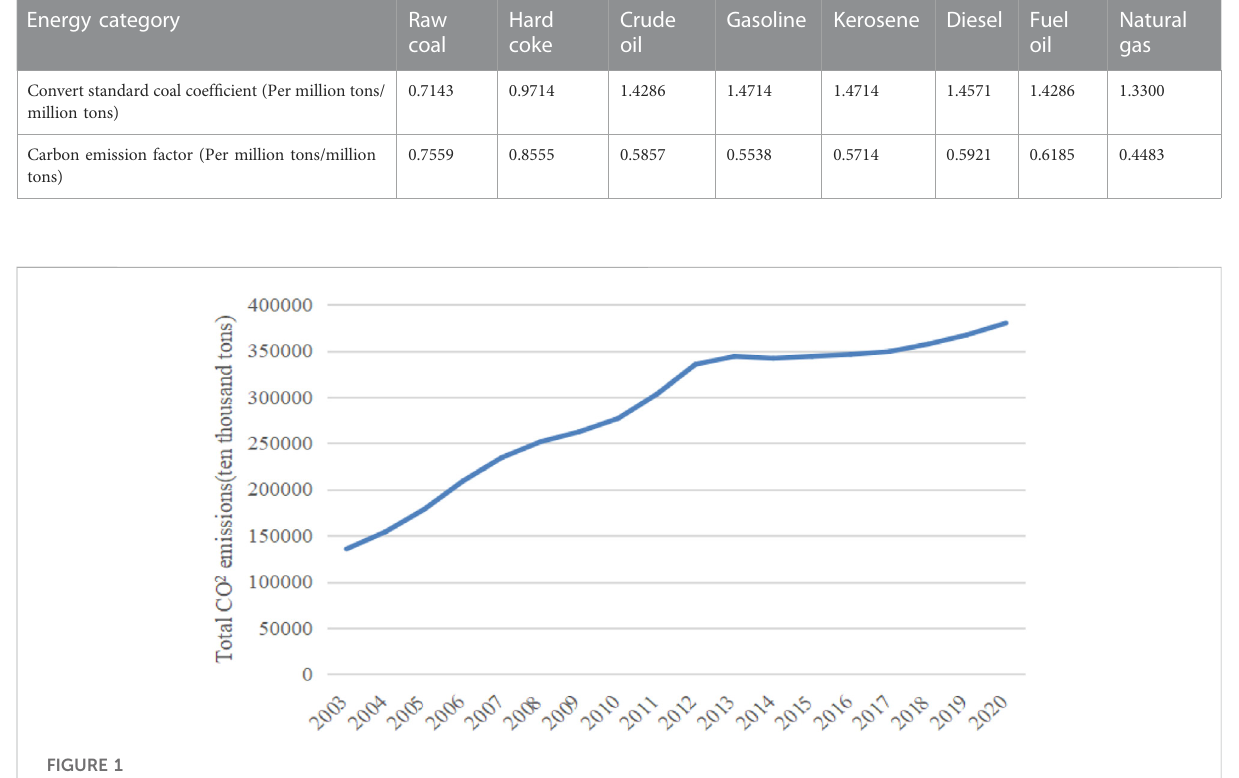
FIGURE 1 Total carbon emissions in China from 2003 to